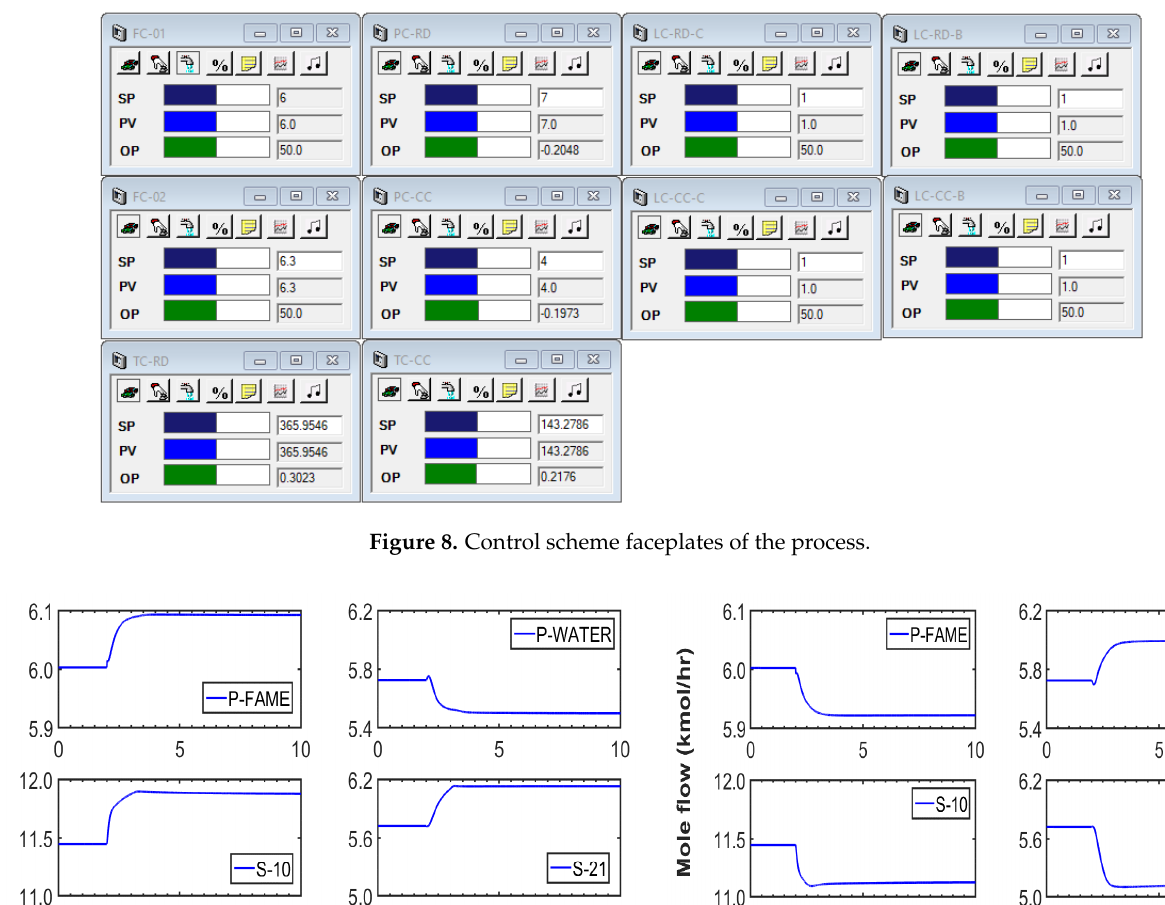
Figure 7. Process flow diagram with control scheme used in Case I (composition control and feed ratio control not in- cluded).